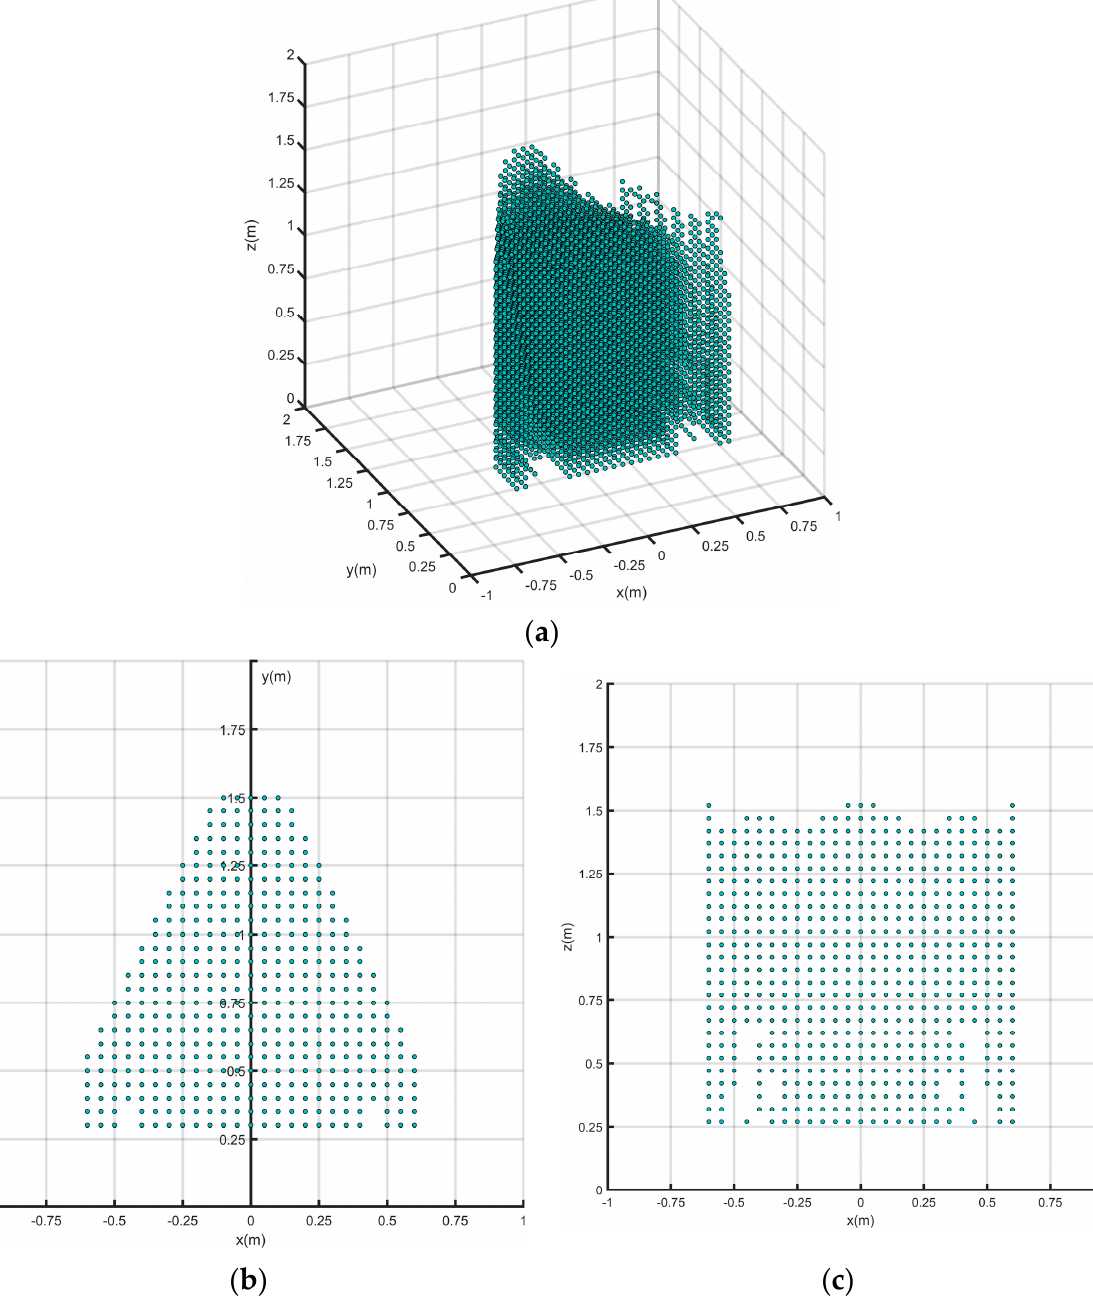
Figure 3. 3 − 6 Static equilibrium workspace of cable-driven parallel robot. ( a ) 3D Static Equilibrium Workspace; ( b ) xoy planar view of Static Equilibrium Workspace; ( c ) xoz planar view of Static Equilibrium Workspace.